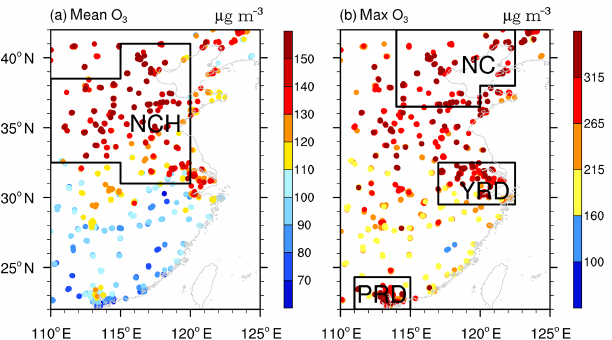
Figure 1. Distribution of the (a) mean values and (b) maximum values of MDA8 (unit: µgm − 3 ) at the observation sites in sum- mer from 2015 to 2018. The black boxes in panels (a) and (b) indi- cate the locations of North China and the Huanghuai region (NCH), North China (NC), Yangtze River Delta (YRD), and Pearl River Delta (PRD).